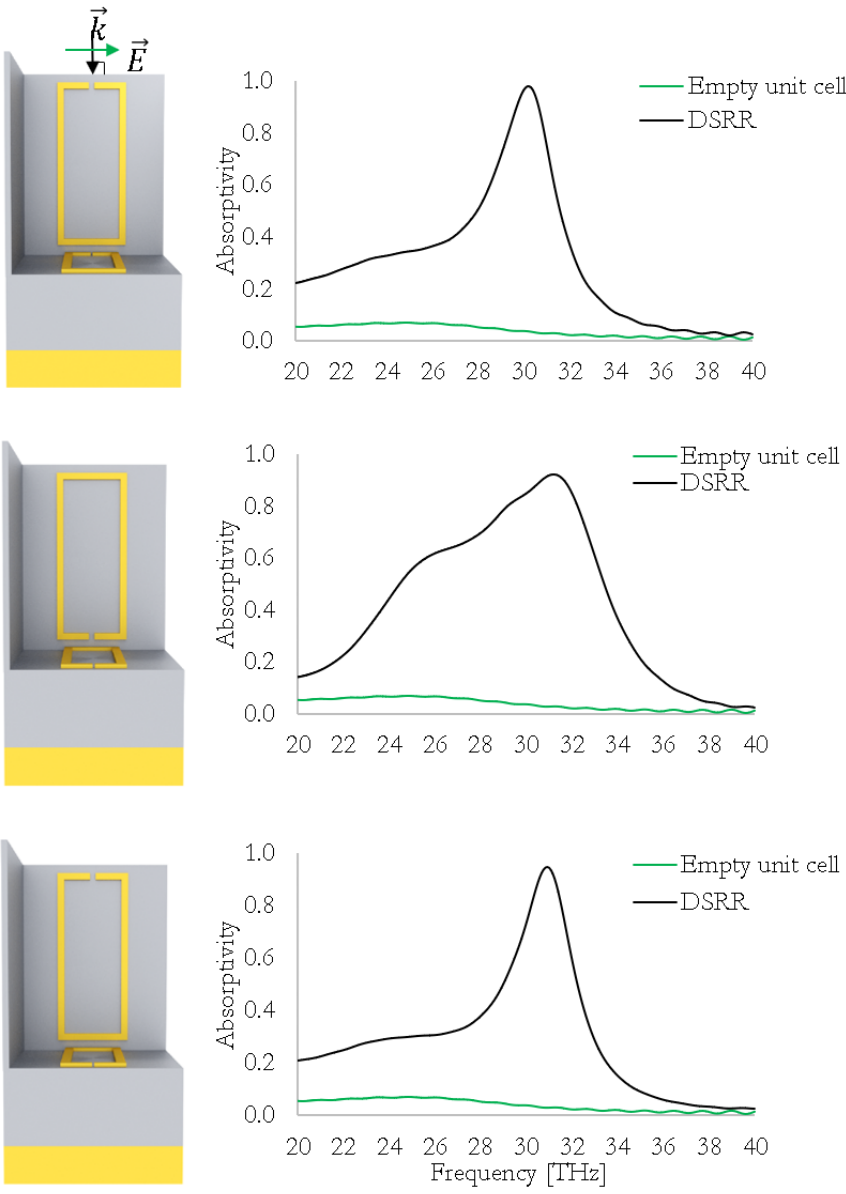
Figure 7. The DSRR geometry is shown with: ( top ) a VSRR rotated 180 ◦ ; ( middle ) a PSRR rotated 180 ◦ ; and ( bottom ) both VSRR and PSRR rotated 180 ◦